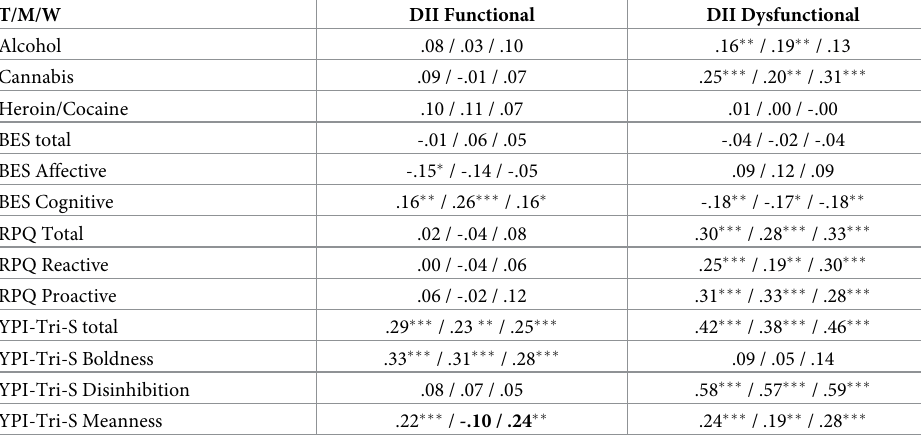
Table 3. Criterion-related validity of the